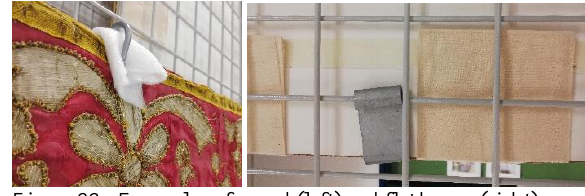
Figure 22 - Examples of round (left) and flat hoops (right). Textile ribbons were used to suspend long pendants, passing them through the loops and attaching to the grids (Figure 23).